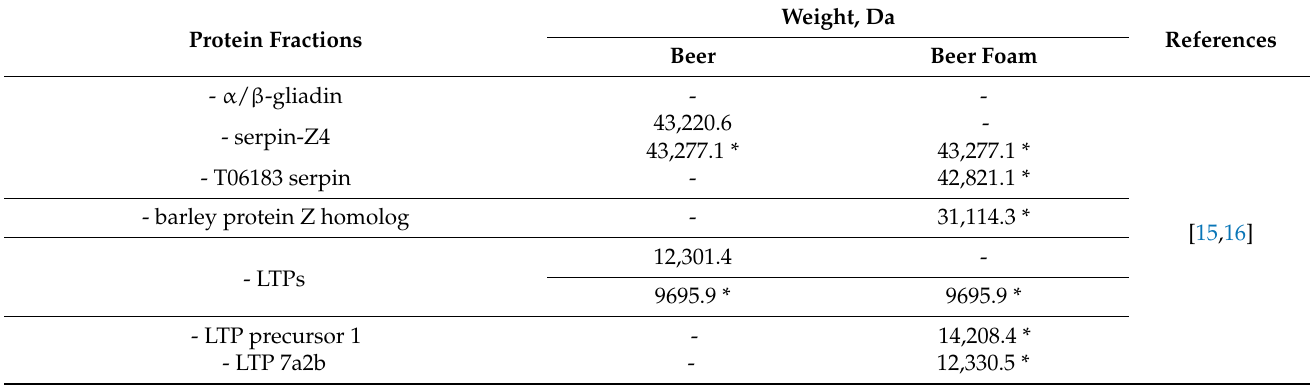
Table 1. The barley-malt beer characteristics of protein